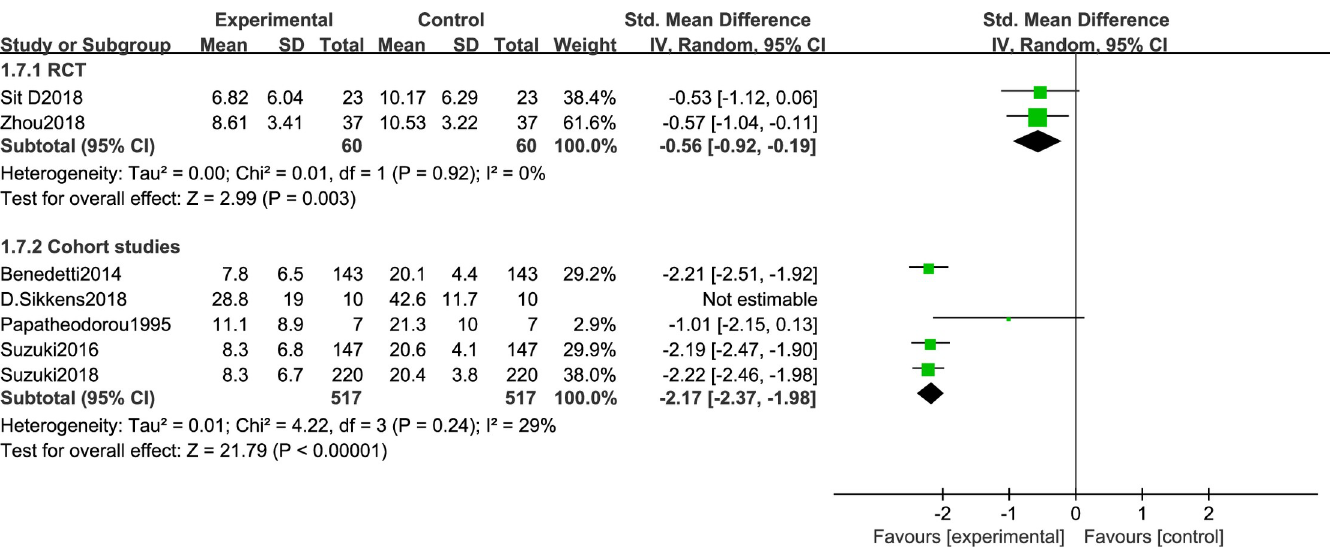
ences between light and control conditions in improvement in depressive symptoms[I 2 = 97%,